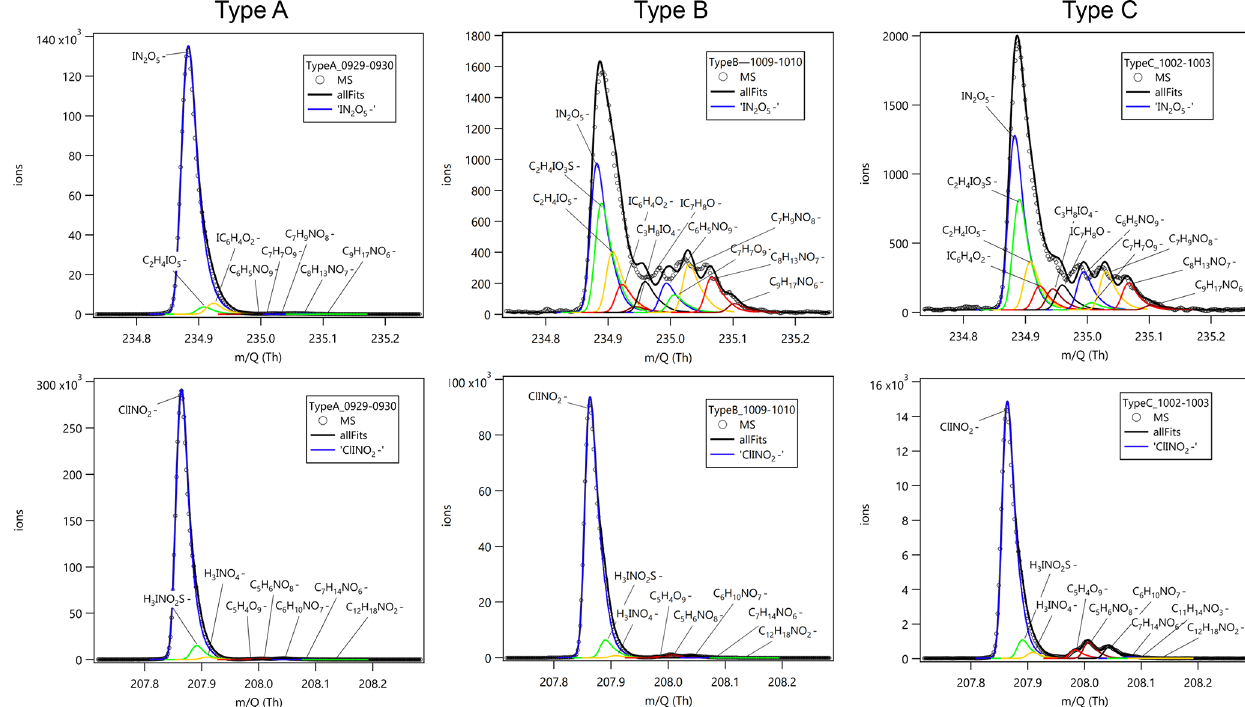
Figure A3. Cases of high-resolution spectra fitting for N 2 O 5 and ClNO 2 by TOF-CIMS under three air mass patterns.